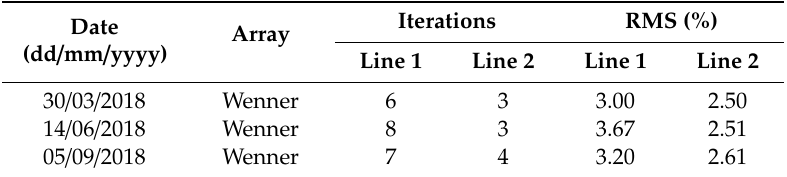
Table 2. Electrical resistivity inversion statistics: number of iterations and root mean squared (RMS) error.